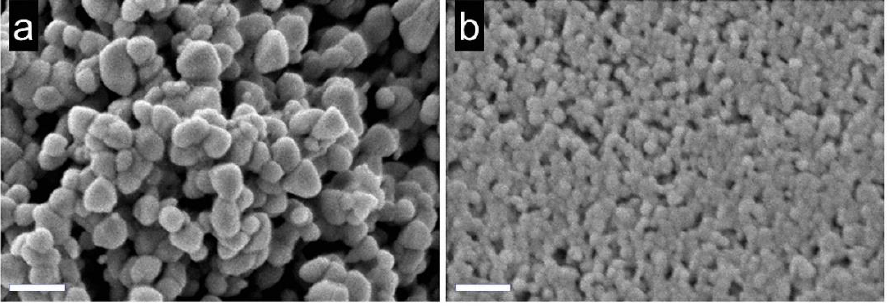
Figure 10. FE-SEM images for ( a ) ZnO (pure) ( b ) 0.5 wt. % Cr/ZnO. Note that scale bars: 100 nm. Obtained from reference [101].